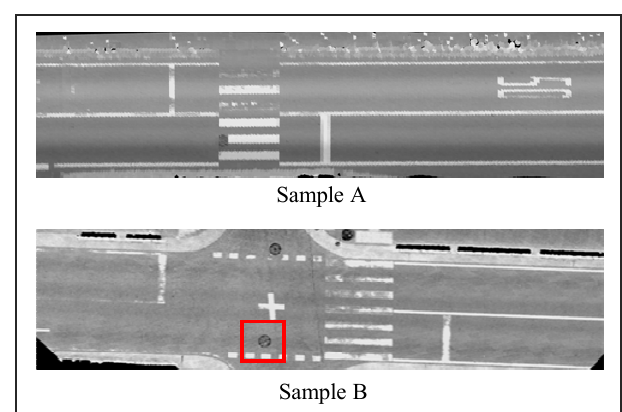
Figure 2. Reflection intensity image